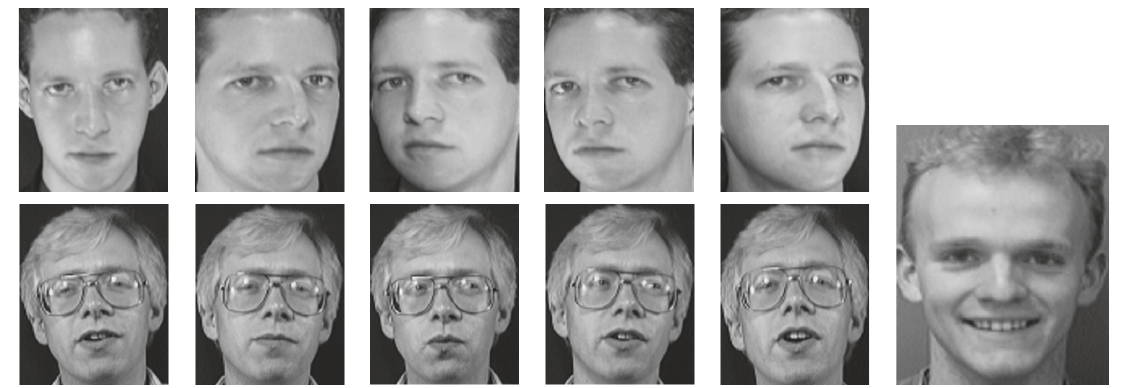
Figure 4: The face images selected from the